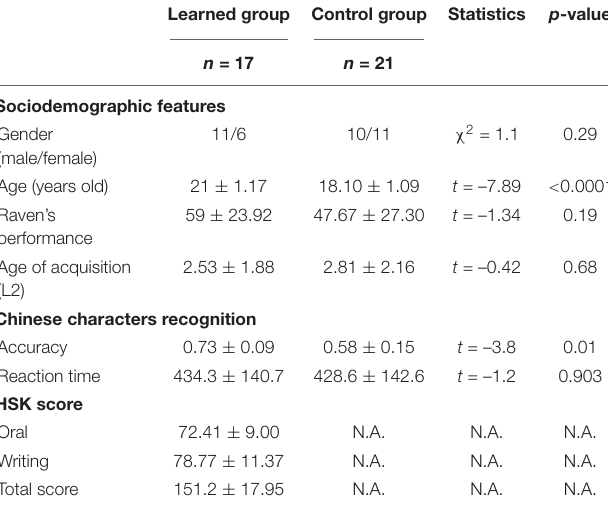
TABLE 1 | Demographic characters and behavioral performance of all